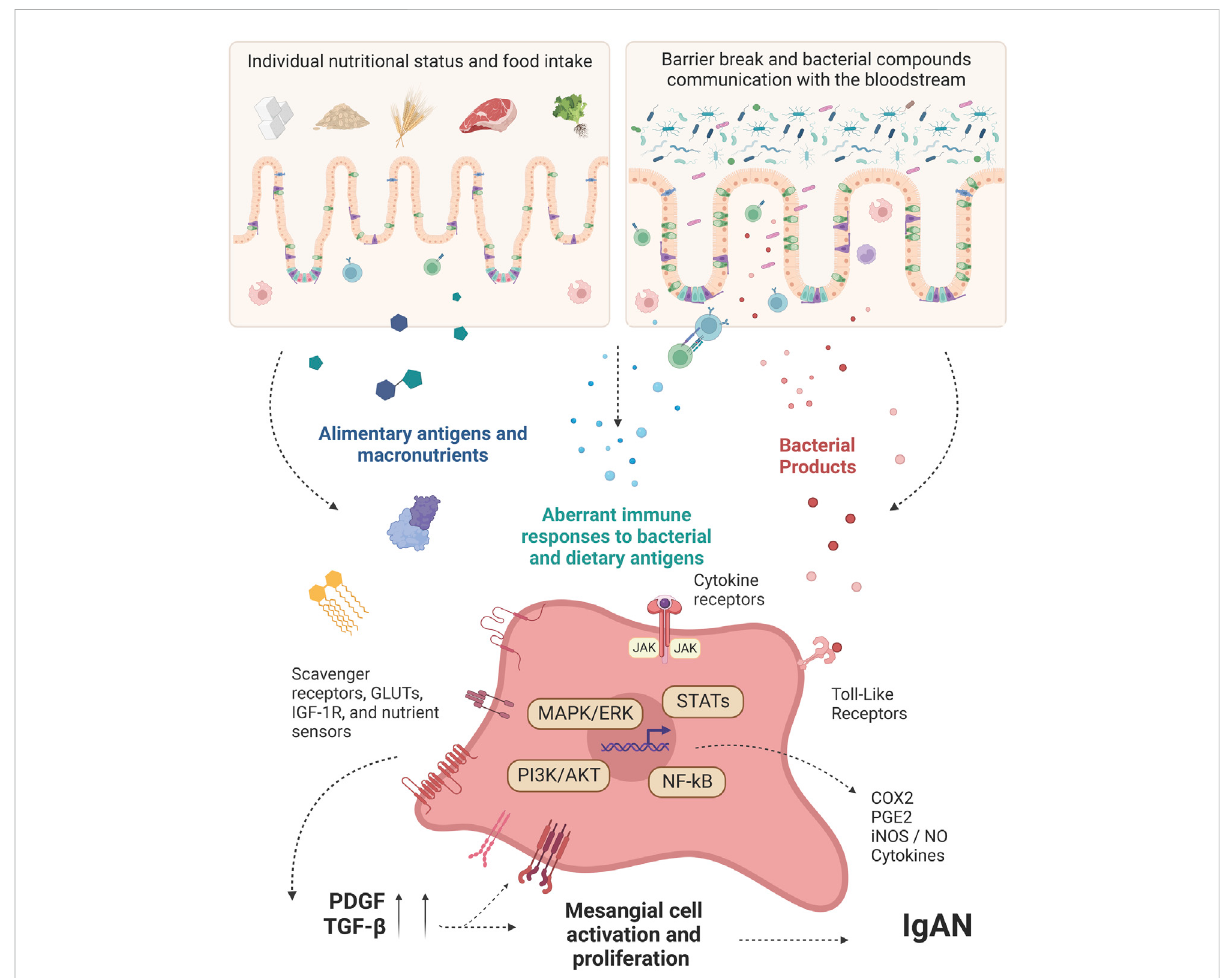
FIGURE 1 Intestinal-derived factors interfering with mesangial cell-intrinsic pathways activation. Diet-derived molecules and bacterial products from the gut of IgAN patients work as antigens, promoting immune cell activation. After a gut-barrier break, these molecules reach the bloodstream and can be recognized directly by the mesangial cells through speci fi c receptors. Other important factors involved in the activation of mesangial cells are cytokines, whichare producedduring mucosal activation and can act systemically, reaching themesangial cells atthe glomeruli. At thecellular level, the ligands can promote not only a metabolic shift but also increase the responsiveness regarding in fl ammatory products by the mesangial cells. This, besides the Gd-IgA1 established model for IgAN, can precede the unique mesangial cell features shown by many IgAN patients, justifying the onset of the disease earlier than the IgA complexes deposition. PDGF: Platelet-derived growth factor; GLUTs: Glucose transporters; NF- κ B: Nuclear factor- κ B; STATs: Signal transducer and activator of transcription; MAPK: Mitogen-activated protein kinase; ERK: Extracellular signal- regulated kinase; PI3K: phosphoinositide 3-kinase; AKT: protein kinase B; JAK: Janus kinase; COX2: Cyclooxygenase-2; PGE2: Prostaglandin